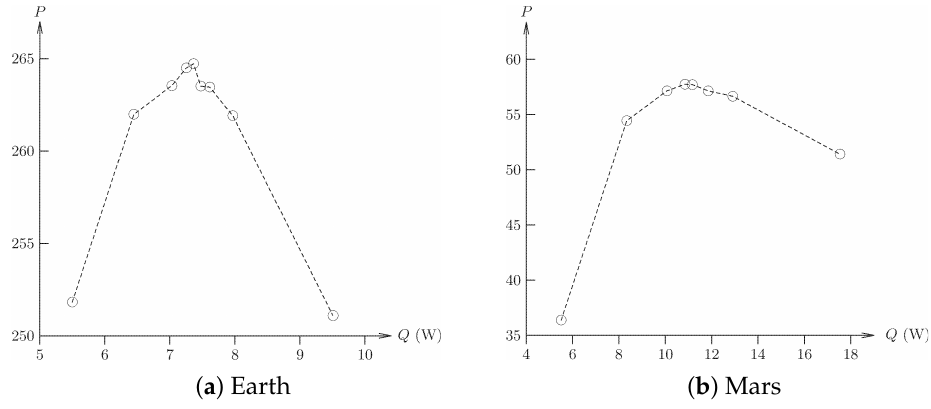
Figure 47. Efficiency of energy